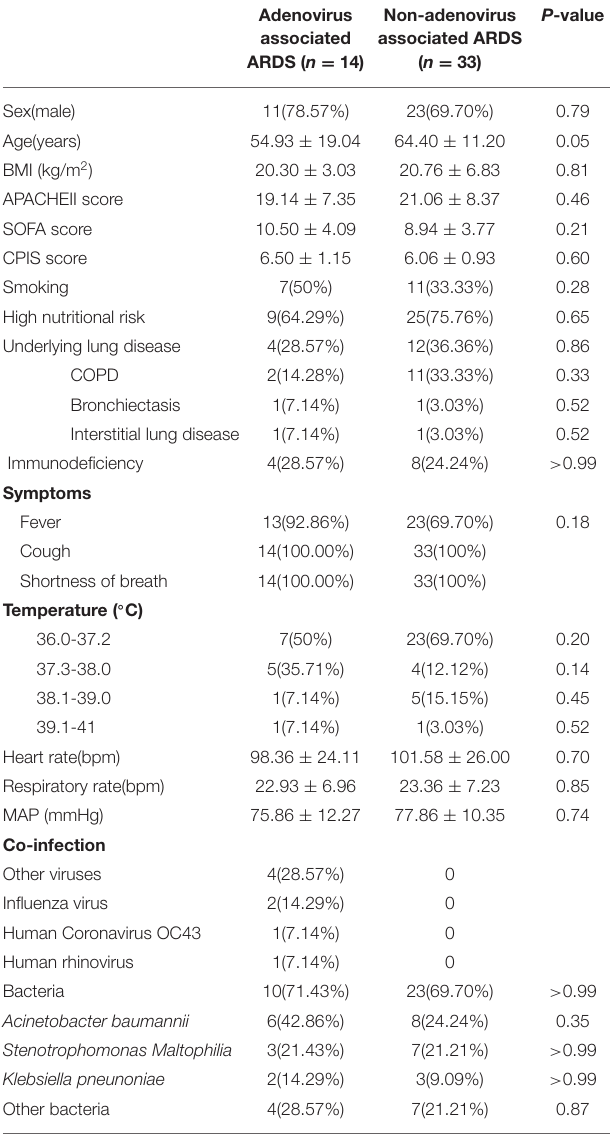
TABLE 1 | Demographic data and clinical characteristics of the patients with adenovirus-associated ARDS and non-adenovirus associated ARDS. Adenovirus associated ARDS ( n =